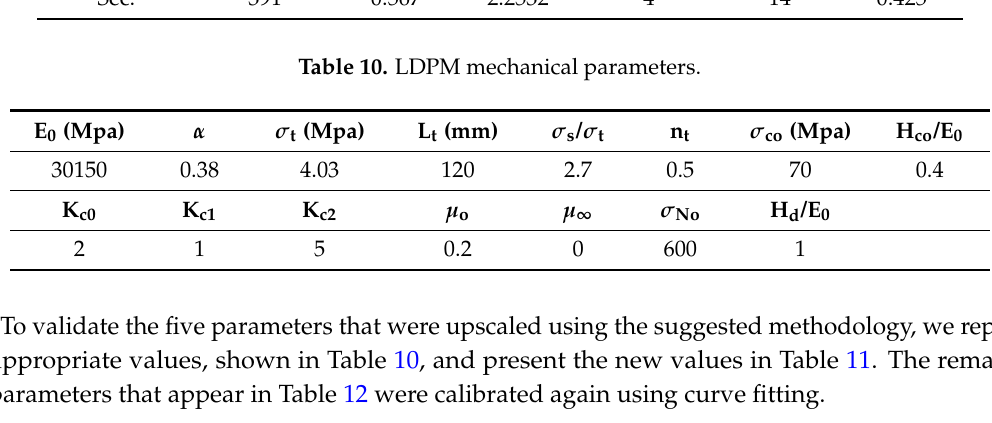
Table 11. LDPM upscaled parameters.